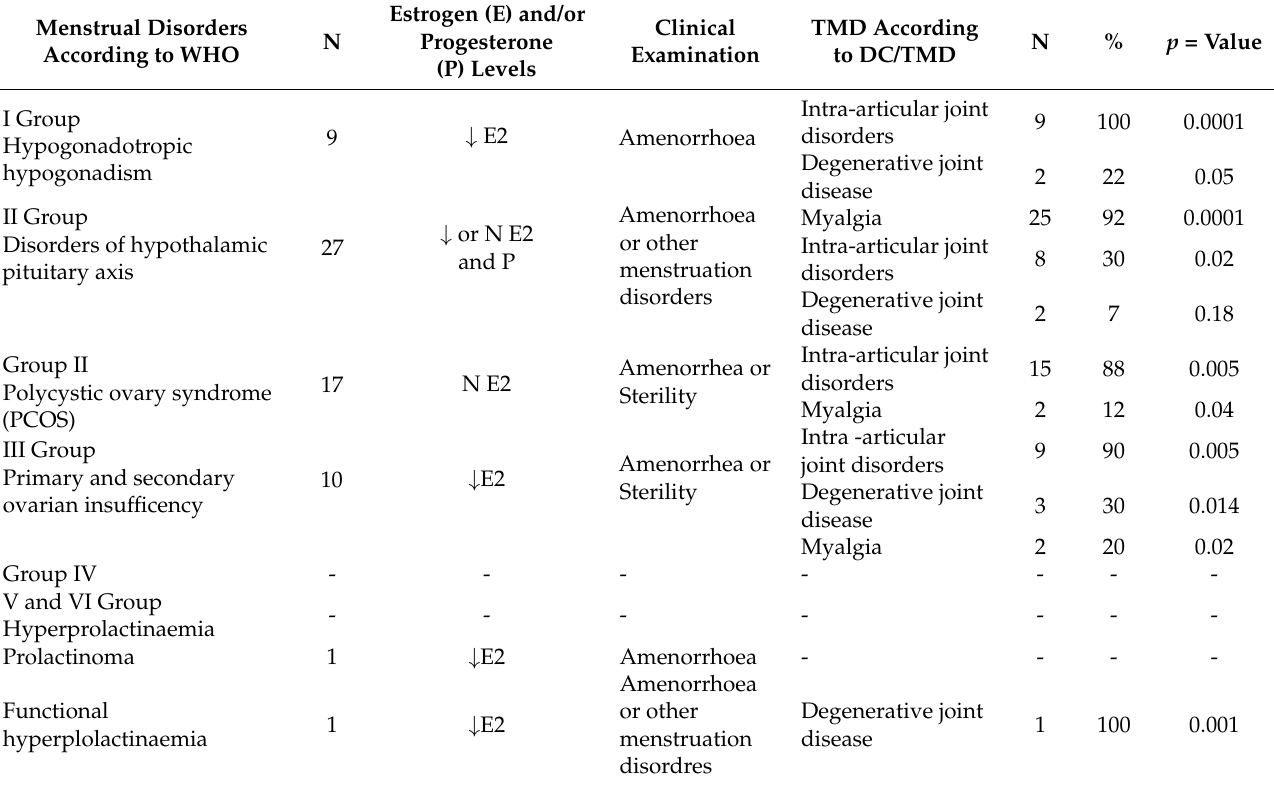
Table 1. Correlation between menstrual disorders and TMD (N =